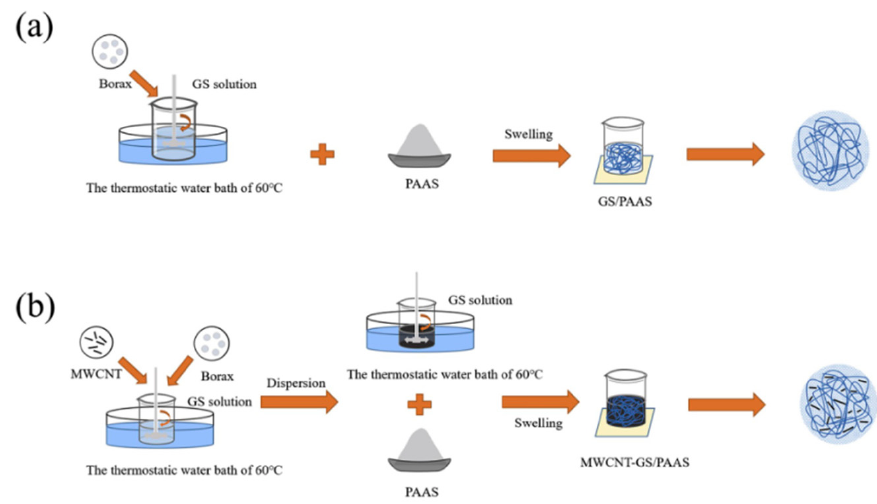
Figure 12. Sample preparation approach used by Liu et al. [99]: ( a ) PCM + GTA and ( b ) PCM + NM + NA + GTA.